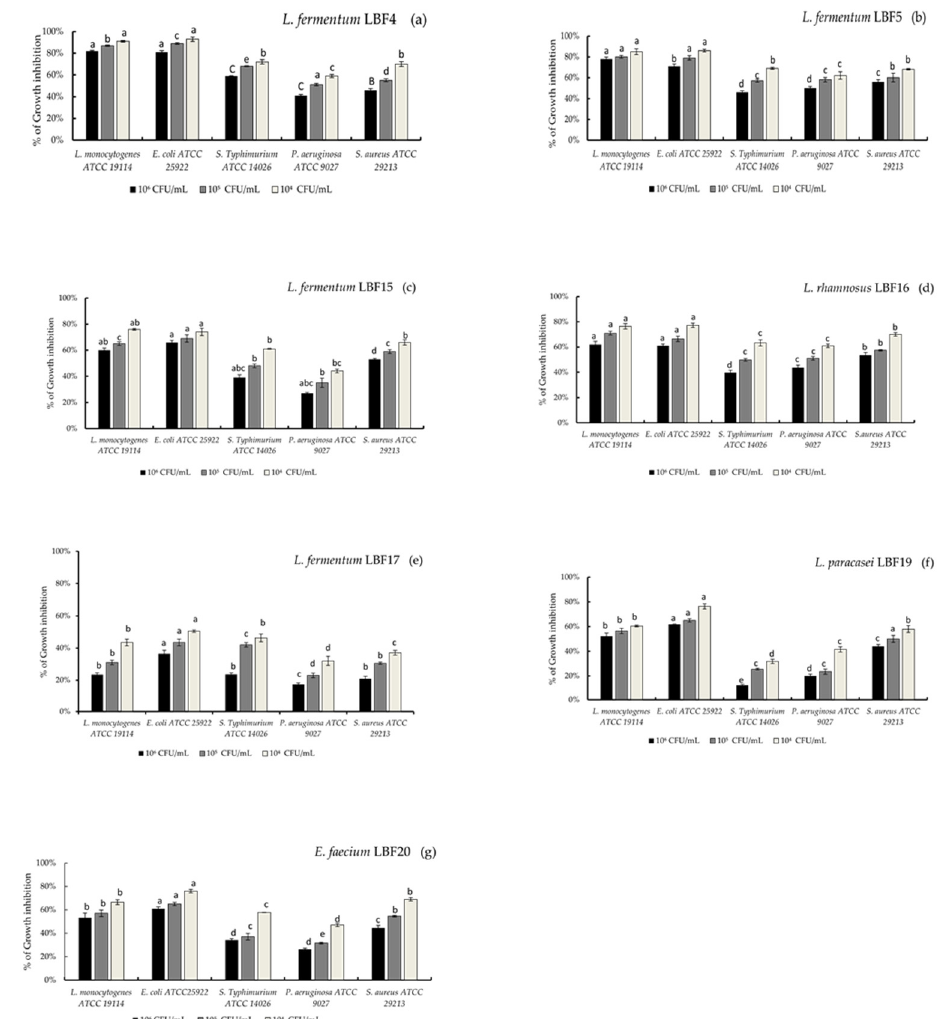
Figure 2. Antimicrobial activity (as percentage of growth inhibition) of L. fermentum species ( a – c , e ), L. rhamnosus species( d ), L. paracasei species ( f ), E. faecium ( g ) species against target bacteria at different concentrations in